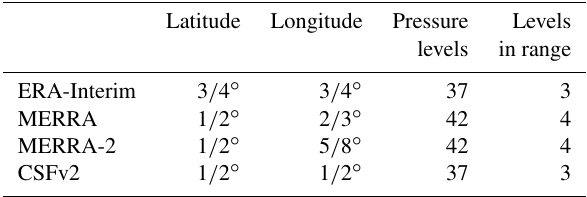
Table 1. Resolution of the model outputs used in this study. The last column identifies the number of pressure levels between 30 and 70hPa inclusive. All model products provided in 6h intervals.